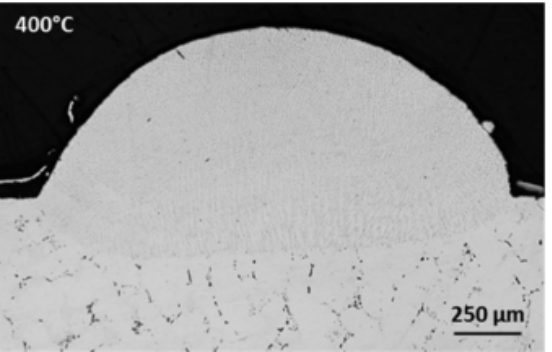
Figure 20. Cracks in HAZ of the CM-247LC substrate disappeared after 400 °C induction preheating (the laser power is 320 w, and the scanning speed is 50 mm/min) [103].